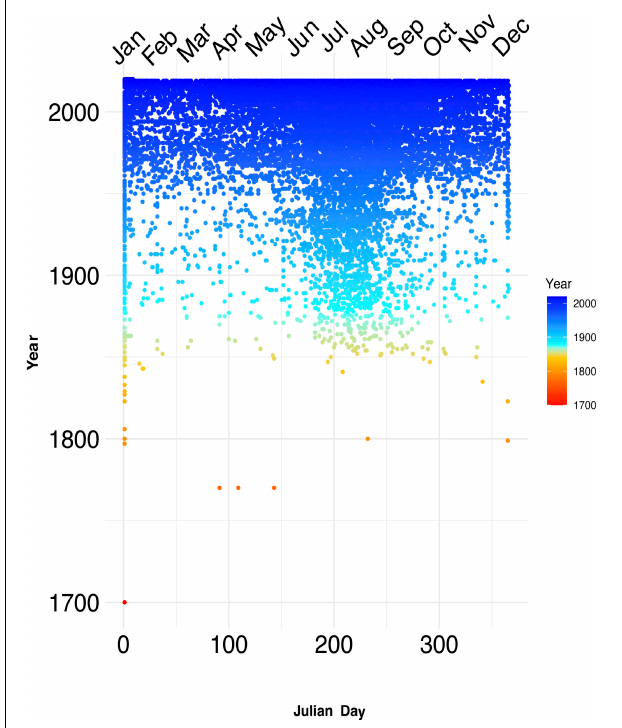
FIGURE 4 | Temporal sampling of seagrasses reveal drastic increases midway throughout the 18th century. Temporal data from seagrass records over the course of three centuries (roughly 1700–2000) display dense amount of sampling records accumulating after 1850. Each dot represents an occurrence record of a seagrass in Julian day of year format, with the color gradient representing recent years with colder color tones, and older years represented by warmer color tones. These data also support the previously identified global trend of increased sampling occurring predominantly within the summer months (early June through early October). Source data are provided as a Source Data